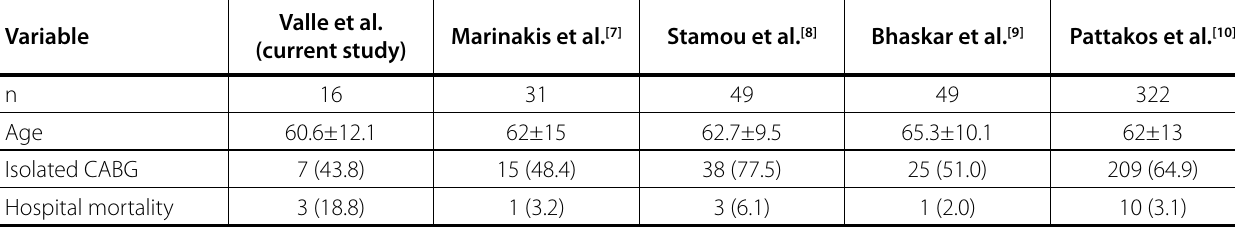
Table 5 . Comparison of current study with previous retrospective comparative studies.